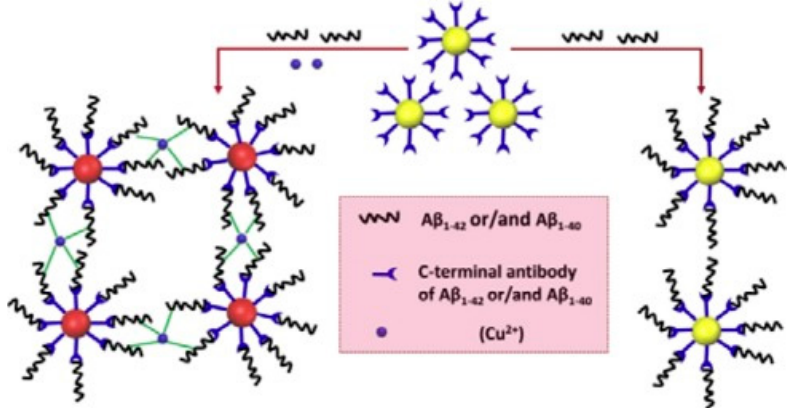
Figure 9. Colorimetric immunosensor for determination of A β (1–40 / 1–42) based on the interaction of A β with Cu 2 + (Reproduced with permission from [88]. Elsevier, 2016).